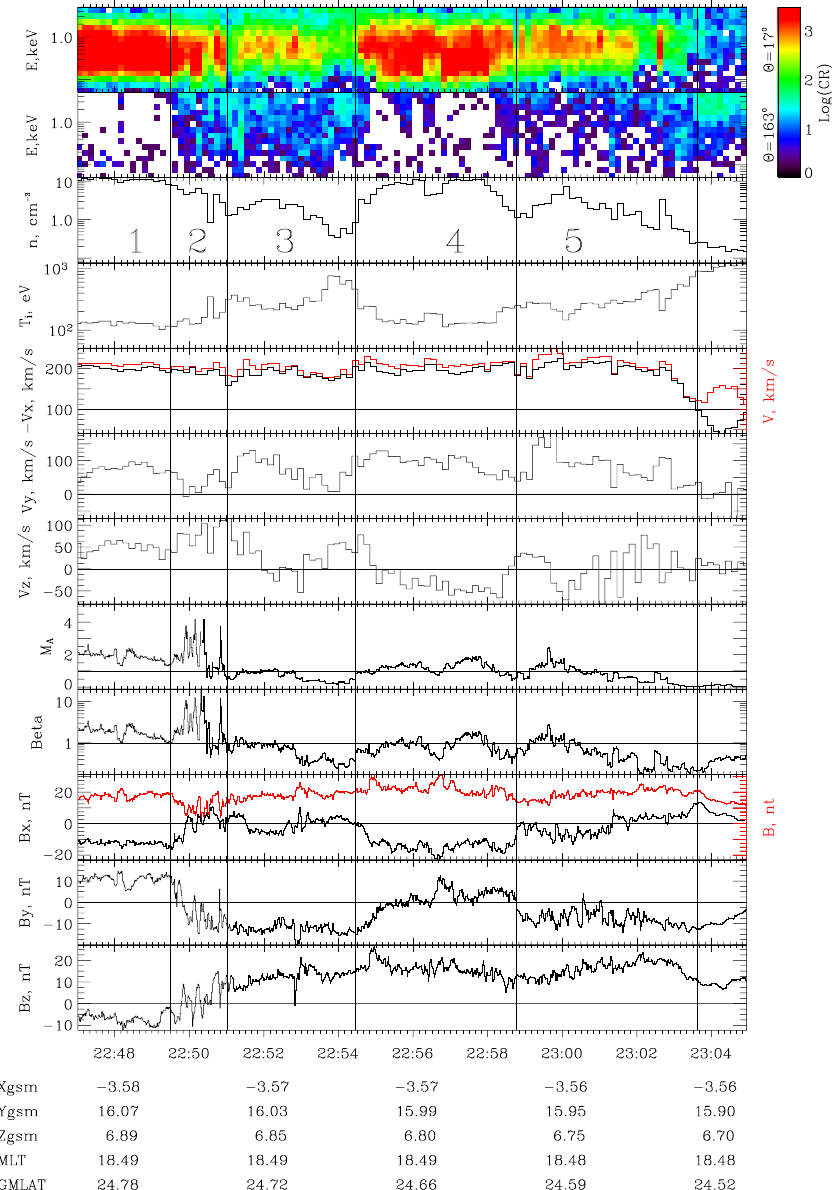
Fig. 2. Magnetopause/LLBL crossing as observed by Interball on 15 February 1996. From top to bottom are shown: two energy-time spectrograms of SCA-1 ion spectrometer, ion flow parameters number density N , ion temperature, total velocity (in red) and V X component (in black), V YGSM component, V ZGSM component, ion Mach number, ion beta, magnetic field magnitude (in red) and B x component, B YGSM component, and B ZGSM component. GSM coordinates of the spacecraft location, magnetic local time, and geomagnetic latitude are shown on the bottom. See text for explanation of different